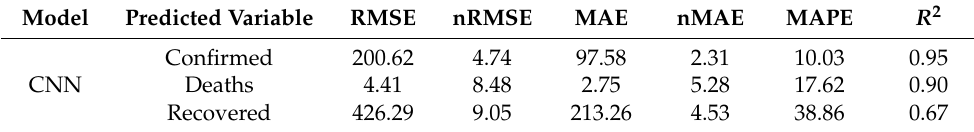
Table 3. Performance evaluation of the test dataset forecasting using the CNN model.